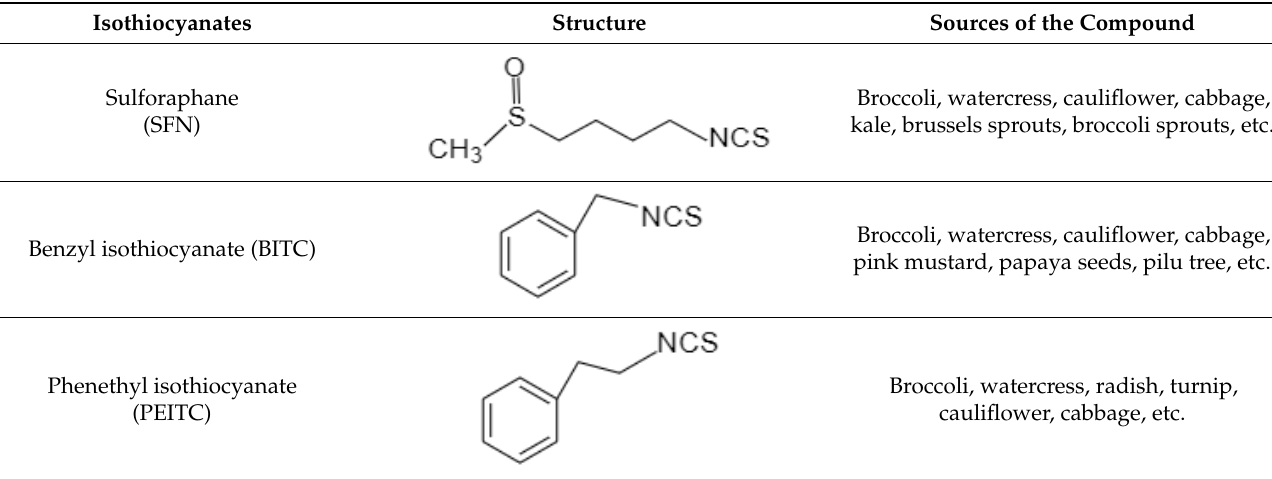
Table 1. Representative table highlighting various Isothiocyanates, including Sulforaphane (SFN), Benzyl isothiocyanate (BITC), and Phenethyl isothiocyanate (PEITC), along with their structure and plant sources. Structures are drawn with ChemDraw Online Software.